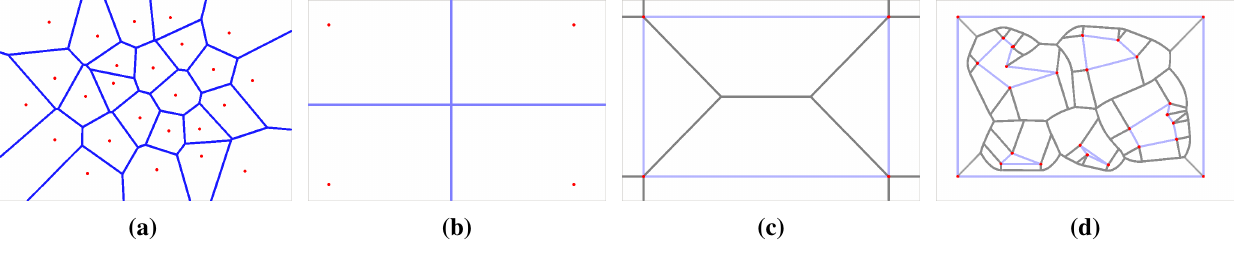
Figure 4. Examples of the ordinary Voronoi diagram for k generating points in a plane and generalized Voronoi graph in walled environment: ( a ) random points, k = 25; ( b ) four points forming a rectangle, k = 4; ( c ) four walls forming a rectangular environment; ( d ) rectangular environment with fives polygonal obstacles with pruned parts of the Voronoi diagram outside the freespace of the polygonal